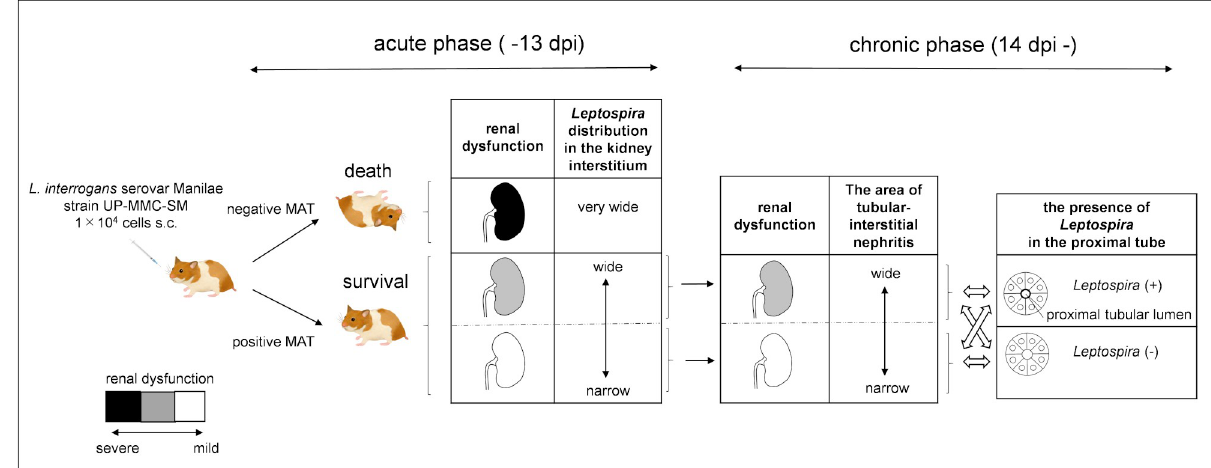
Fig 8. Hamster model of acute and chronic leptospirosis with subcutaneous infection. The color scale of the longitudinal section of the kidney indicates the degree of renal dysfunction. Subcutaneous infection with pathogenic leptospires could cause acute death in hamsters, whereas recovery from acute infection led to chronic leptospirosis. If antibody production is initiated during the acute phase when leptospires colonize the kidney and proliferated there, the growth of leptospires is suppressed and hamsters survive. On the other hand, if antibody production is delayed, leptospires become overloaded and hamsters die. Leptospira distribution in the kidney of surviving hamsters was expected to be narrower than that of dead hamsters in the acute phase. The distribution of leptospires in the kidney during the acute phase may affect the chronic renal damage due to tubulointerstitial nephritis. Some hamsters showed leptospiral colonization in the renal proximal tubule lumen during the chronic phase, which was not correlated with elevated serum creatinine levels. The arrows (black) show the passage of time. The double-headed arrow (white) shows the relationship between renal dysfunction and the presence of Leptospira in the proximal